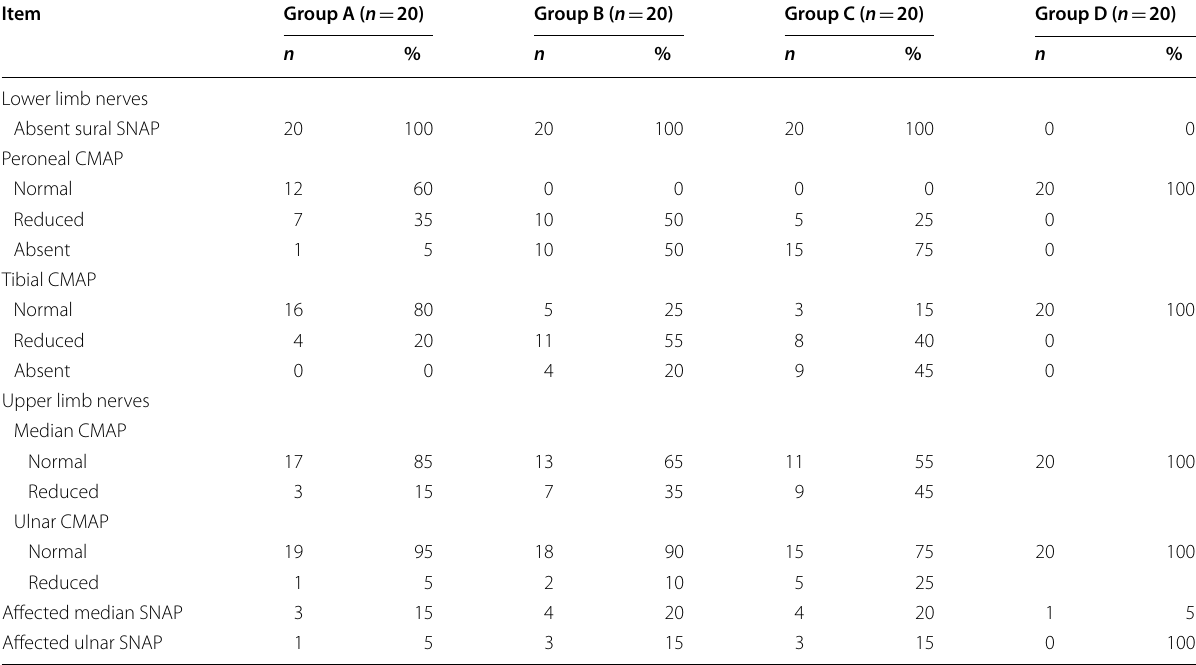
Table 3 Nerve conduction study of patients